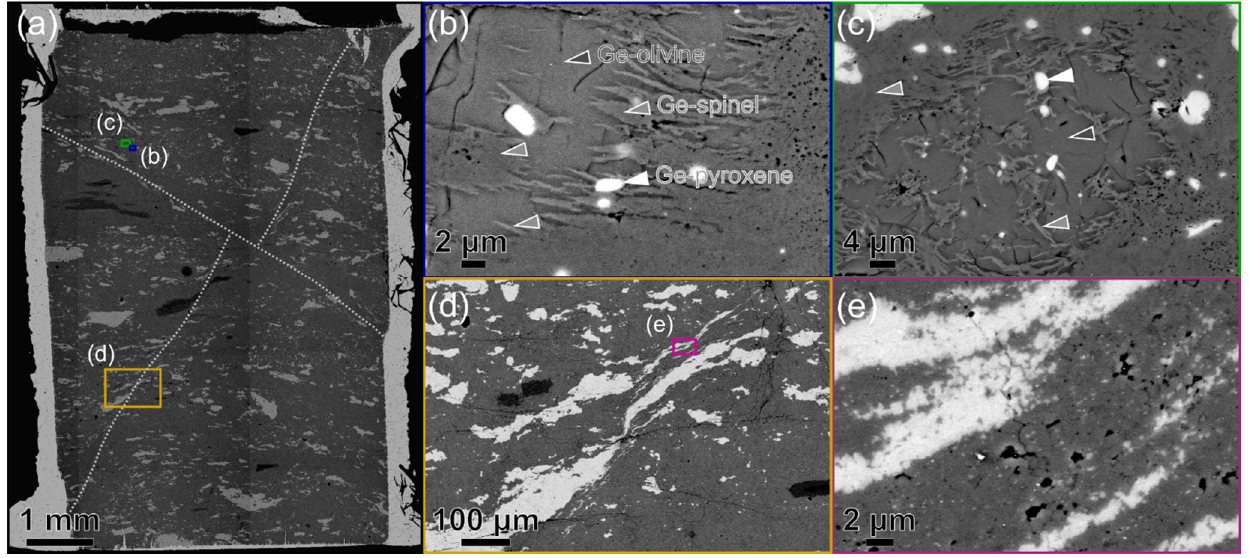
Figure 6. SEM images of sample G43 (834 °C). Compression direction is vertical on all images. ( a ) Image of the entire sample. The gold capsule is visible on the sides. The brighter phase corresponds to Ge-pyroxene; the gray bulk of the sample corresponds mostly to Ge-spinel along some residual Ge-olivine grains. Several shear bands are observed; the two largest ones are highlighted by the dashed lines. ( b , c ) High magnification images in an undeformed part of the sample, where relict Ge-olivine is found (dark gray arrowheads). Rounded Ge-pyroxene grains evidence negligible deformation (white arrowheads). Ge-spinel grew as lenses, mostly oriented normal to the principal stress direction (light gray arrowheads). ( d ) Detailed view on a shear zone according to the rectangle in ( a ). Elongation of Ge-pyroxene grains reveals strain localization along shear bands that are a few tens of microns to hundreds of microns wide. ( e ) High magnification image of the shear band show in ( d ). Ge-olivine is fully reacted to Ge-spinel. The shear band is extremely fine-grained with equi- axed grains of both Ge-pyroxene and Ge-spinel. Some phase mixing occurred, as attested by the spotty nature of the Ge-spinel at the center of the shear band. Strain is localized on conjugate planes in both samples, despite the ductile behaviour suggested by the mechanical data (Figure 7). In the BSE images, the dramatic shearing of the Ge-pyroxene grains evidences that these apparent faults are mylonitic shear bands. They are composed of fully reacted Ge-spinel that recrystallized into small euhedral grains. Phase mixing with Ge-pyroxene is incipient in most cases and attests to important strains. Grain size of both Ge-pyroxene and Ge-spinel within the shear bands is <1 µm, which attests to substantial dynamic recrystallization, since the initial average grain size of Ge-pyroxene in the HIP sample—still observed in undeformed regions of the samples— is ~23 µm.